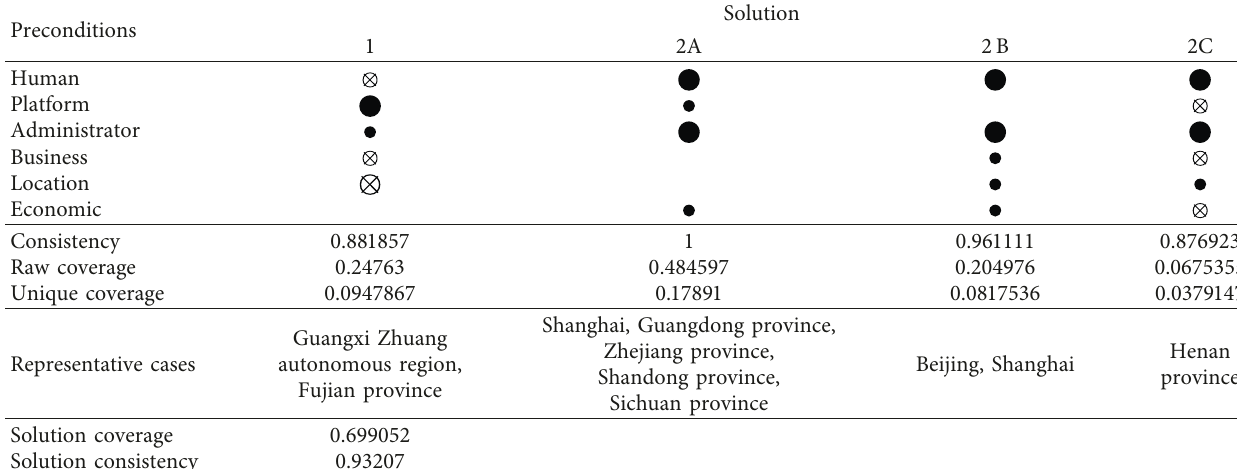
Table 4: Configuration analysis report of the way to promote the market-oriented utilization of government open